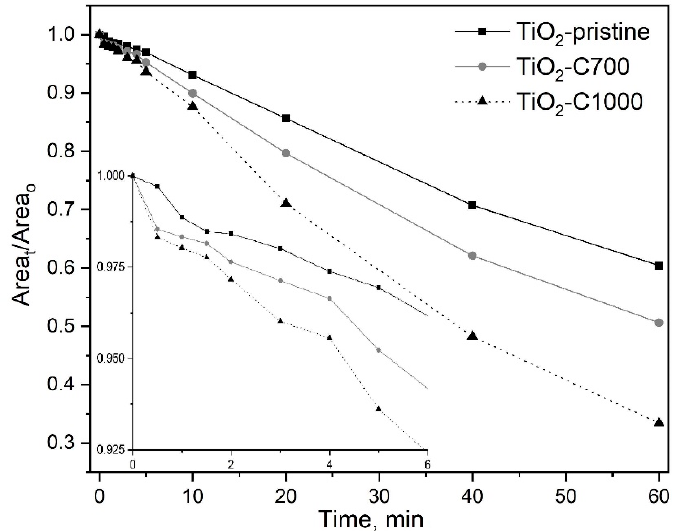
Figure 6. Desorption rate of organic groups from the surface of TiO 2 samples under UV–VIS irradiation at room temperature.